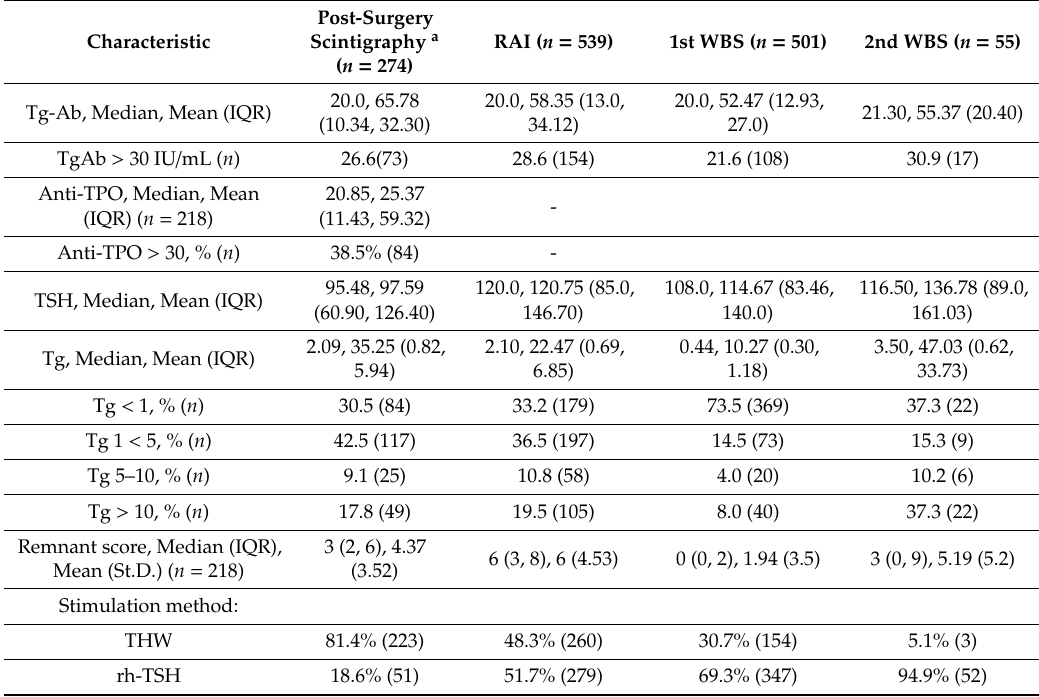
Table 3. Diagnostic, treatment, and follow-up characteristics (median-extreme values or percentage- number of cases) at each time point.